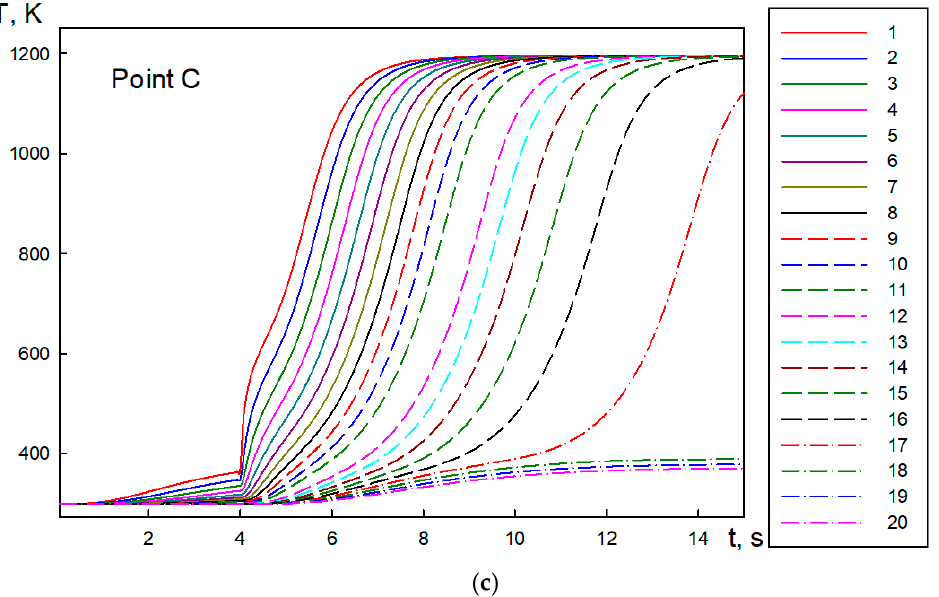
Figure 10. Temperature change over time: ∆ t = 4 s, L= 69 mm, d = 6.5 mm: 1—h = 4.5 mm, 2—h = 6.5 mm, 3—h = 8.5 mm, 4—h = d = 10.5 mm, 5—h = 12.5 mm, 6—h = 14.5 mm, 7—16.5 mm, 8—18.5